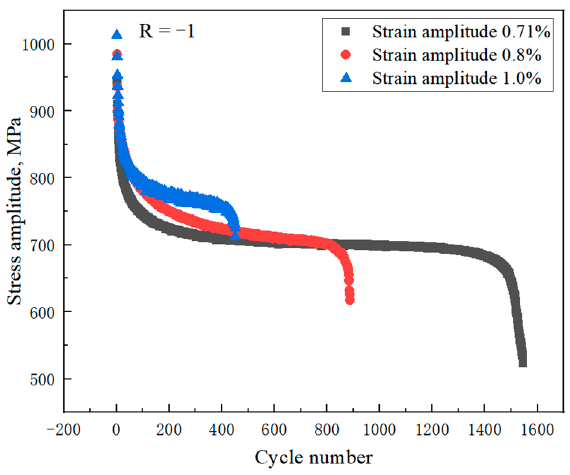
Figure 5. Results of cyclic softening characteristic test of GH4169 alloy.